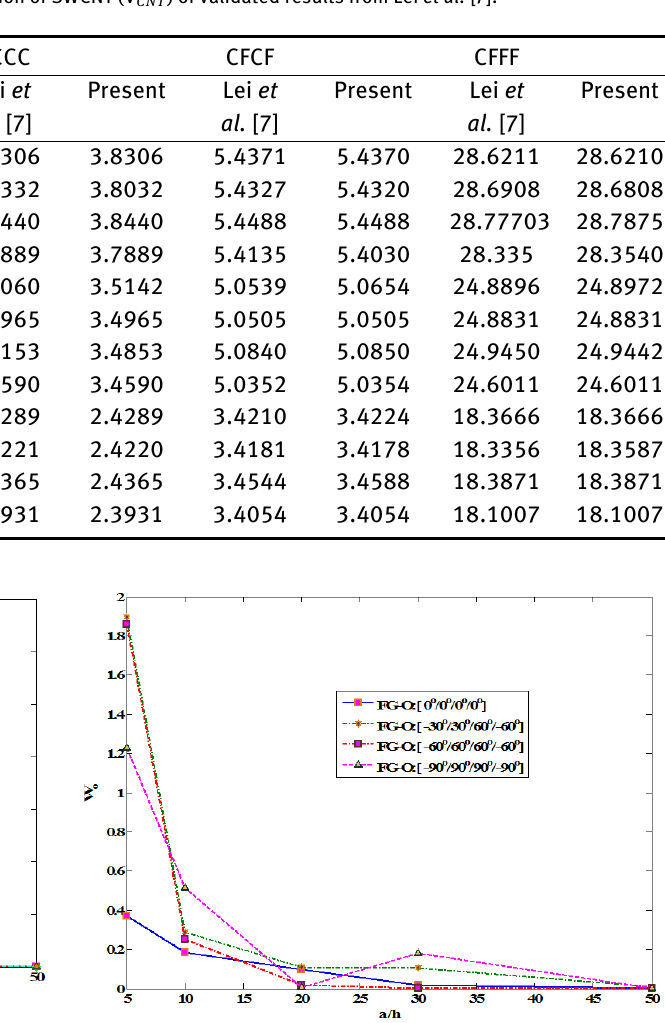
Table 1: Non-dimensional displacement based on volume fraction of SWCNT (V CNT ) of validated results from Lei et al. [7].